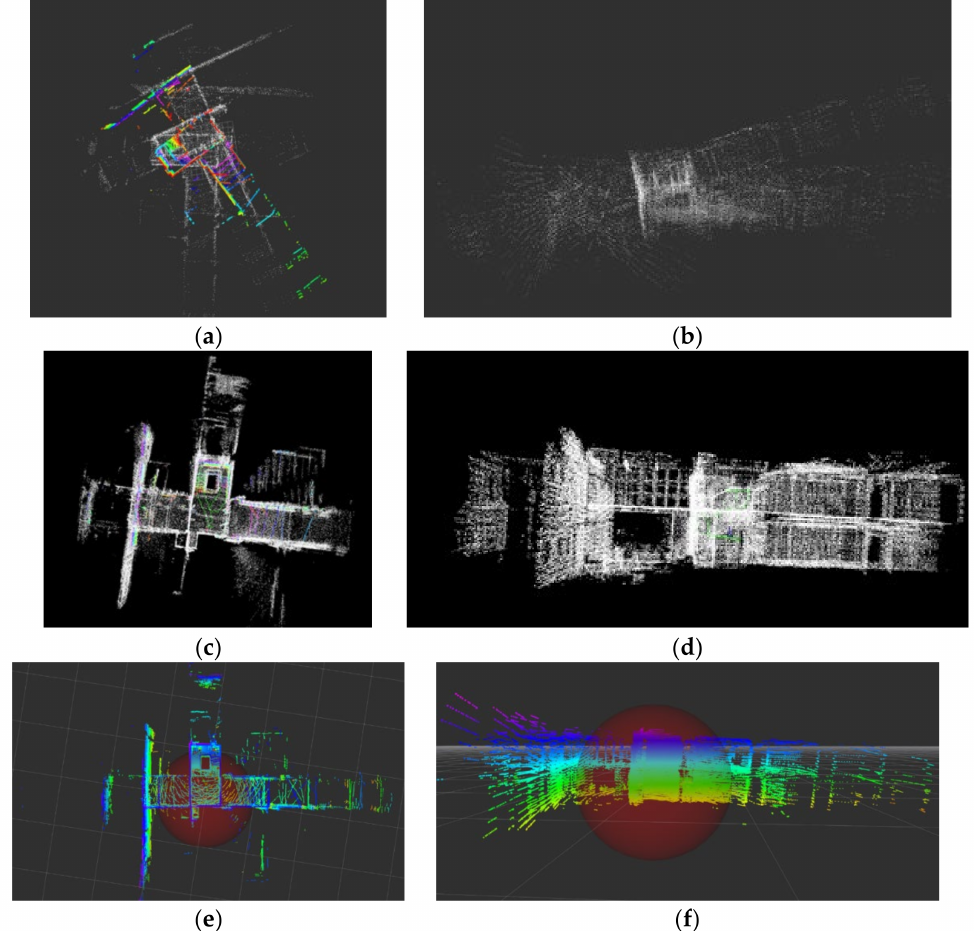
Figure 3. Results of the SLAM algorithms for staircase: ( a ) top view of LOAM results; ( b ) side view of LOAM results; ( c ) top view of A-LOAM results; ( d ) side view of A-LOAM results; ( e ) top view of HDL Graph SLAM results; ( f ) side view of HDL Graph SLAM